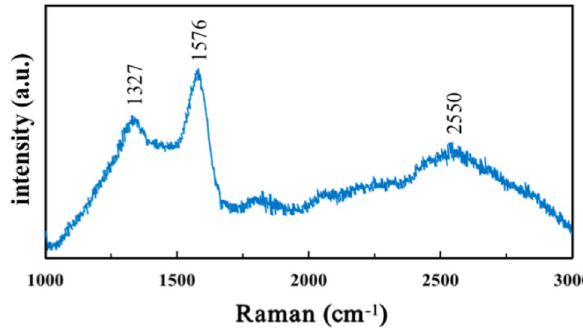
Figure 5. Raman spectra of the fern-leaf carbon sample.